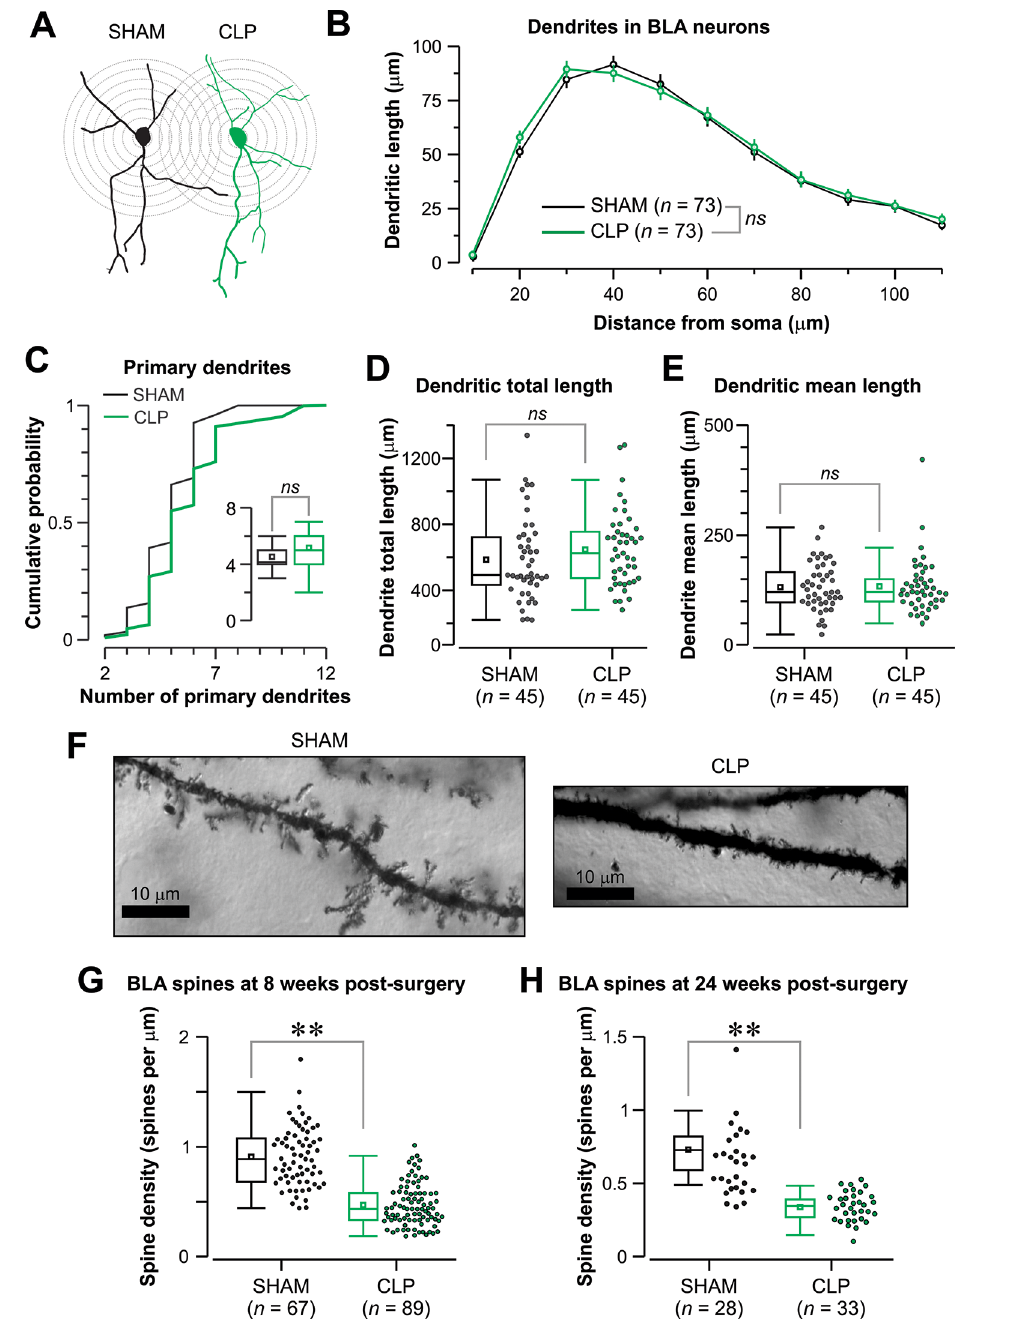
Figure 5. Altered dendritic spine density of BLA neurons in CLP-exposed mice. (A) Traces of representative Golgi-stained BLA neurons from the sham and CLP groups. Concentric rings illustrate the dendritic Sholl analysis, using concentric circles whose diameter expands in 10 μ m intervals. (B) The graph shows the length of BLA dendrites (obtained from Sholl analysis) versus distance from the cell body. Values are not significantly different between groups ( ns , not significant; P = 0.99, D = 0.18, Z = 042, Kolmogorov-Smirnov test). (C) The graph shows that the cumulative probability of the distribution of primary dendrites for both groups is comparable (inset shows box plots; ns, P = 0.045, t test). (D–E) Box plots of dendritic measurements are comparable for total length (D, ns, P = 0.23, t test), and mean length (E, ns, P = 0.88, t test). (F) Micrographs show abundant dendritic spines in the sham dendrite (left) and fewer spines in the CLP dendrite (right). (G–H) Box plots of spine density show that the CLP group has significantly fewer spines than the sham group for the BLA dendrites at (G) 8 wks and (H) 24 wks post-surgery. Statistics, ** P < 0.01 by t